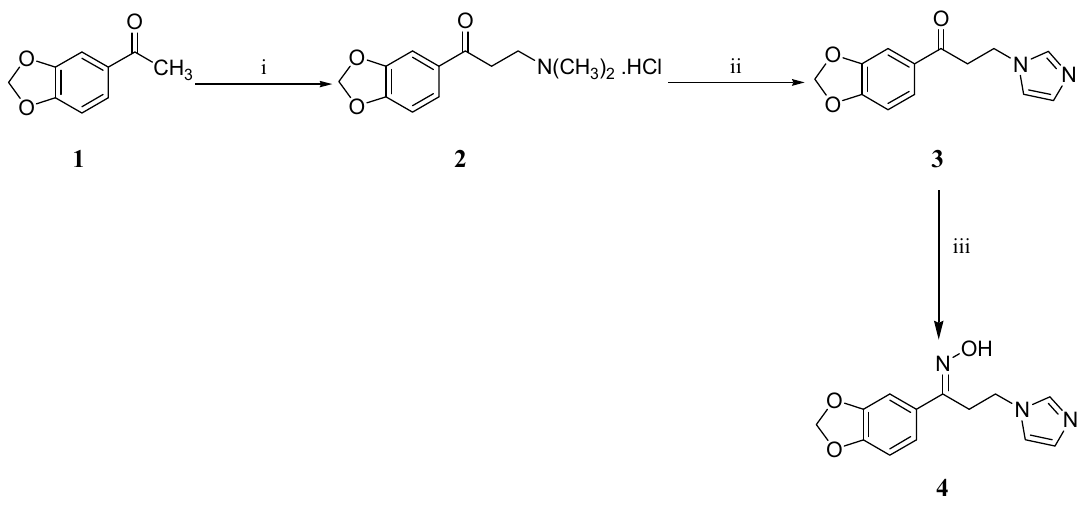
Scheme 1. Synthesis of the target oxime 4 . Reagents and conditions :(i) HN(CH 3 ) 2 .HCl, (CH 2 O) n , conc. HCl, ethanol, reflux, 2 h; (ii) Imidazole, water, reflux, 5 h; (iii) H 2 NOH.HCl, KOH, ethanol, reflux, 18h.